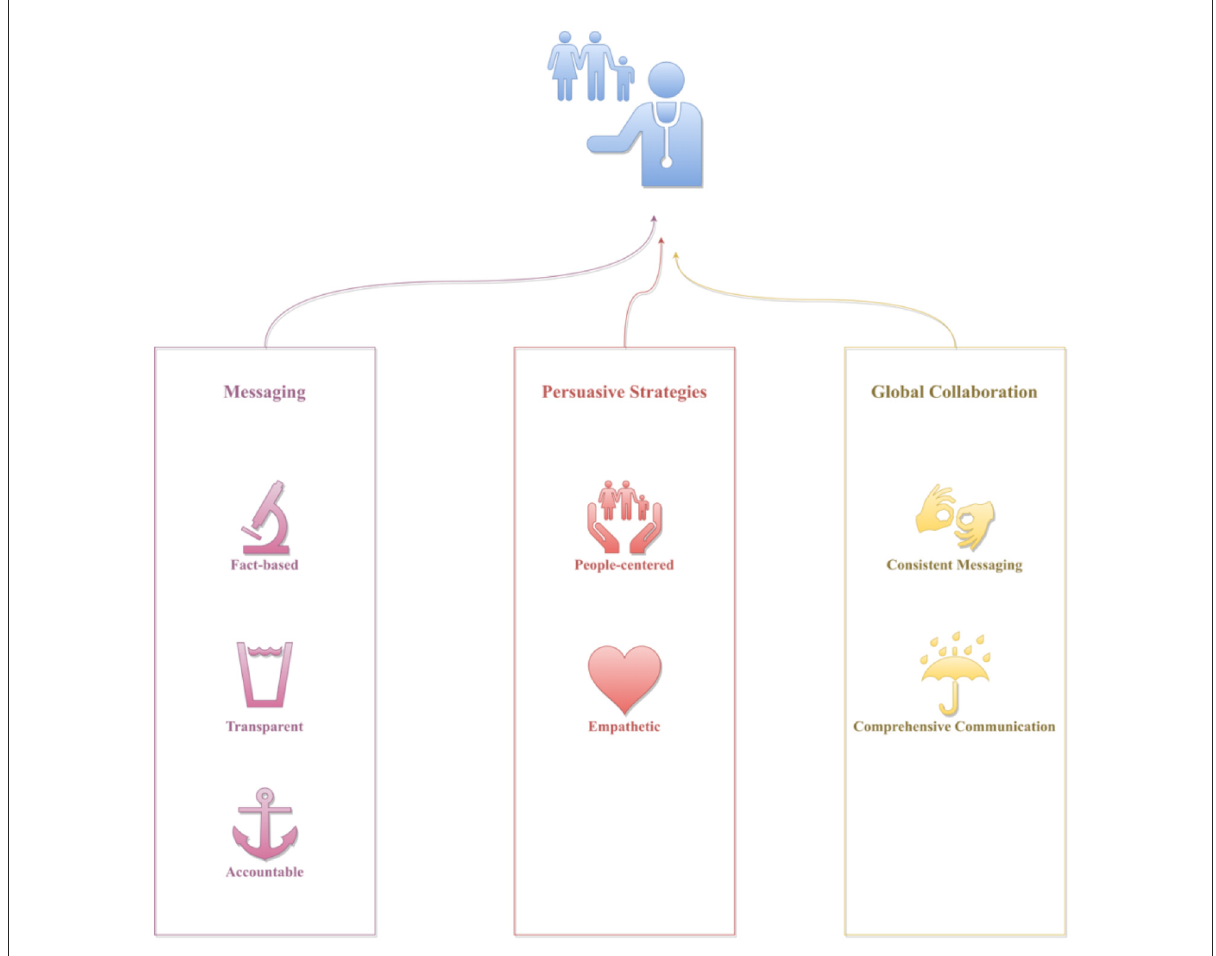
FIGURE2 A schematic representation of the identified crisis communication